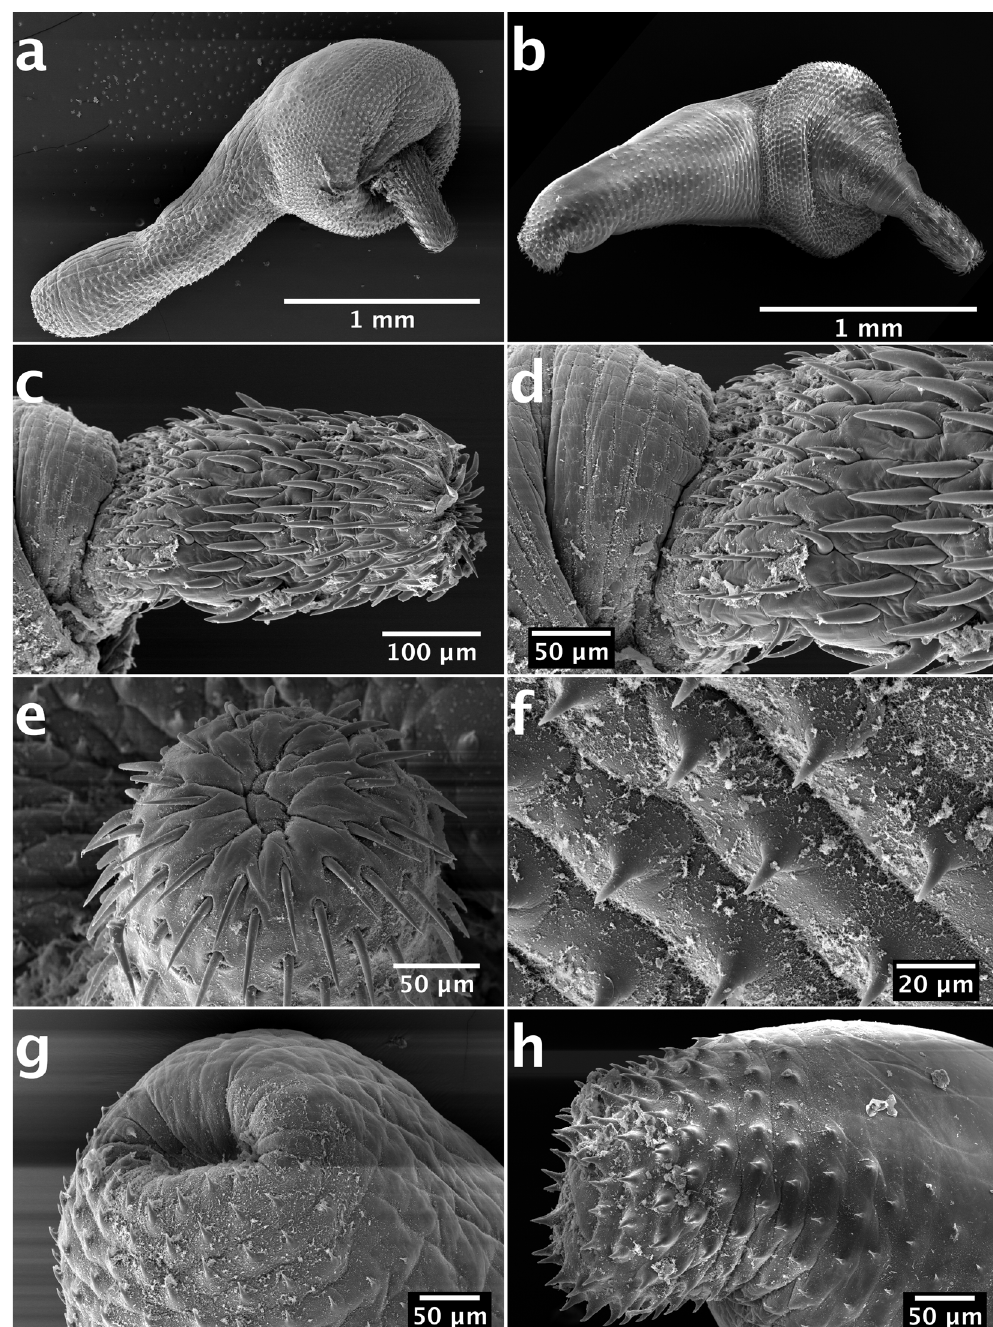
Fig. 5. SEM micrographs of Corynosoma semerme from grey seals, Halichoerus grypus, in the Swedish Baltic Sea. a . ♀, entire worm, ventro-lateral view, from the Bothnian Sea, Hälsingland, Stocka. Spines cover the entire ventral surface of the hind-trunk. b . ♂, whole worm, ventral view, from the Bothnian Sea, Hälsningland, Stocka. Ventral spination of the entire hind-trunk and numerous genital spines. c . Proboscis of a ♀, ventral view, showing the arrangement of the hooks. d . Base of proboscis of a ♀, lateral view, showing the spineless neck and the posterior and middle series of hooks. e . Anterior end of proboscis of a ♀ showing the bare tip. f . Trunk spines of the fore-trunk of a ♂, ventral view. g . Posterior end of a ♀ showing the trunk-spines that extend over the ventral surface as far as the gonopore. h . Posterior end of a ♂ with numerous genital spines